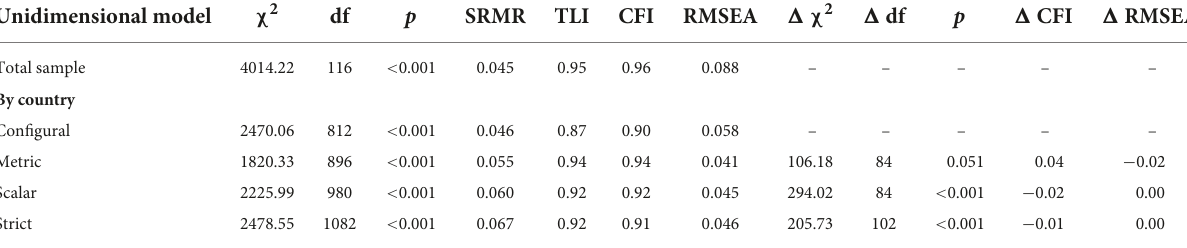
TABLE 4 Fit indices of the invariance models by country of the participants. Unidimensional model